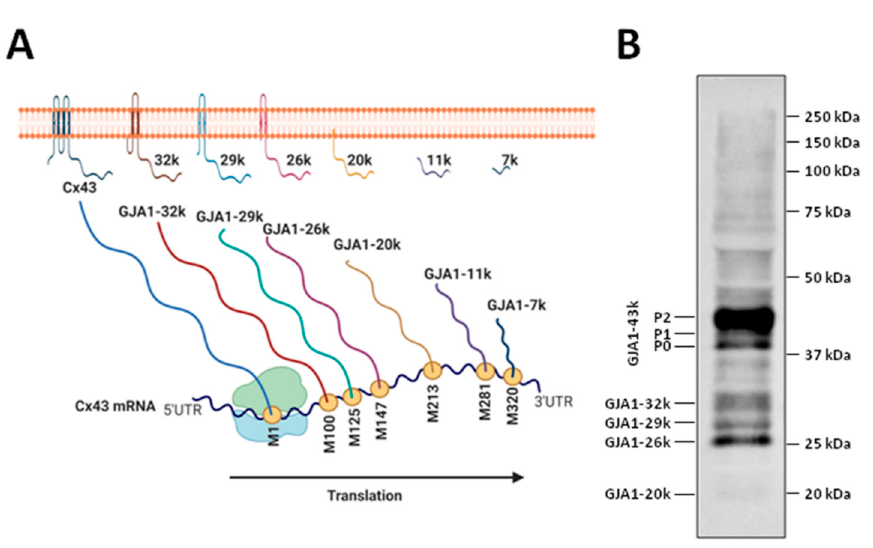
Figure 7. ( A ) Schematic representation of the GJA1 transcript encoding Cx43 and up to 6 putative N-terminally truncated forms. Suggested internal translation initiation sites corresponding to starting AUG codons, encoding for methionines, are shown as yellow circles. Created with Biorender.com (accessed on 15 April 2021). Modified from [8,577]. ( B ) Representative Western blot showing expression of full-length Cx43 (P2, P1 and P0 phosphorylation states), together with the putative N-terminally truncated isoforms GJA1-32k, GJA1-29k, GJA1-26k and GJA1-20k, in tissue extracts obtained from a normoxic isolated rat heart.